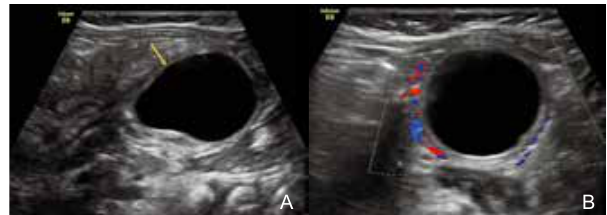
Figure 5 The ultrasonic examination of a girl (age: 3 months) showing intussusception secondary to intestinal duplication which was confirmed by surgery. (A) The long axis showing the “sleeve sign”. Ultrasonography revealed cystic masses (arrow) at the neck of the intussusception with walls showing an intestinal wall-like structure; (B) CDFI revealed dot-like blood flow signals at the wall of the cystic mass.